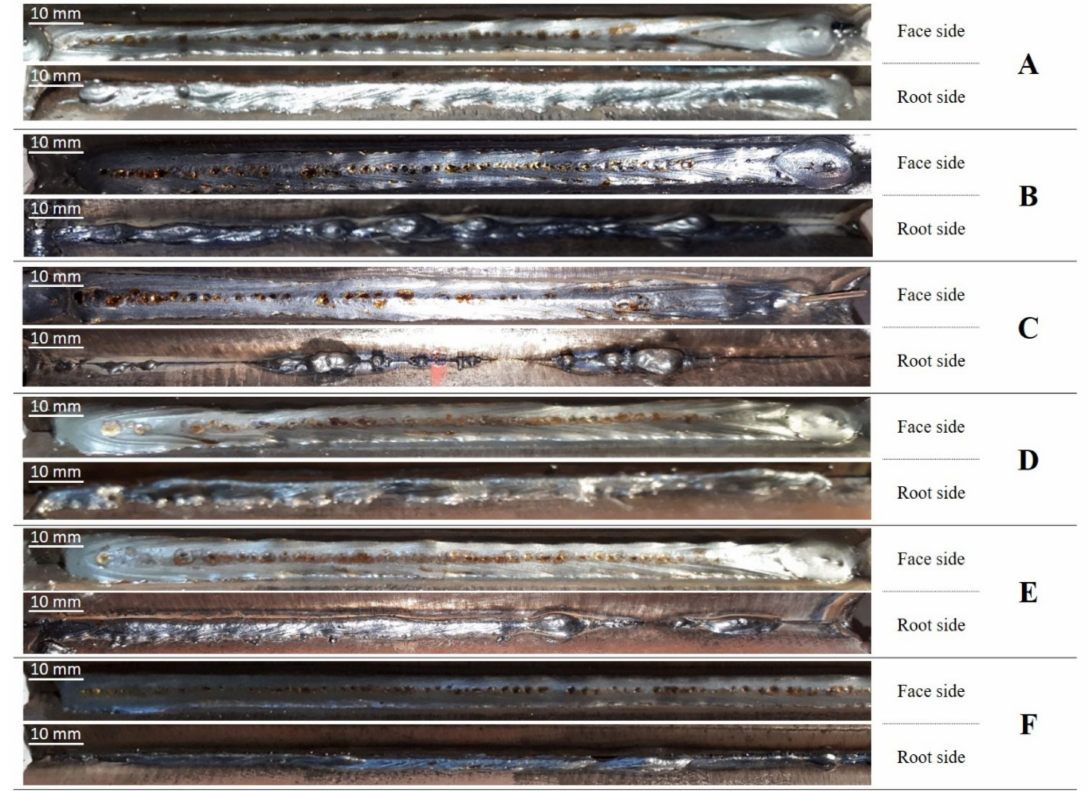
Figure 4. Top view macrographic images of face and root sides at A–F weld beads, as indicated in Table